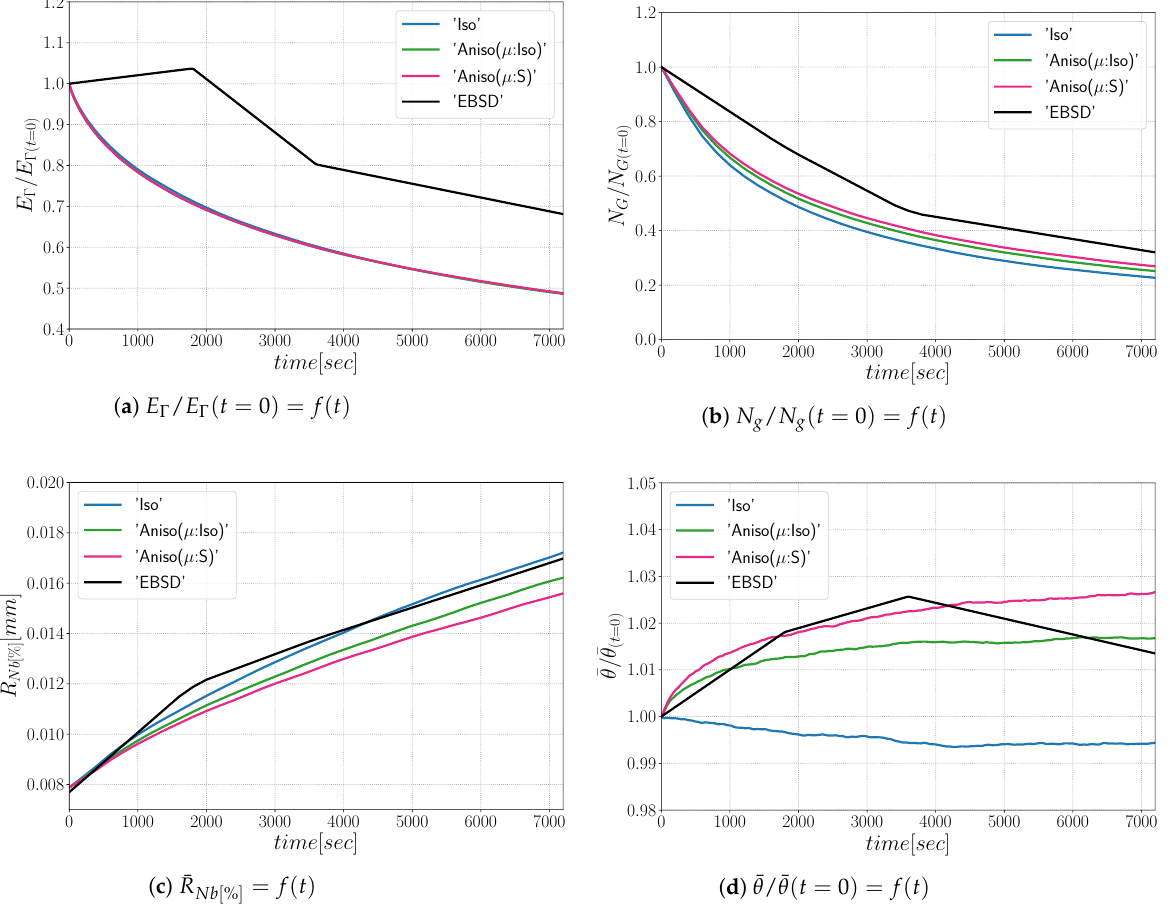
Figure 14. Mean values time evolution for the isotropic (Iso) formulation, anisotropic formulations with isotropic GB mobility (Aniso( µ :Iso)) and heterogeneous GB mobility (Aniso( µ :S)), and the experimental data (EBSD). Numerical results obtained from the initial microstructure shown in Figure